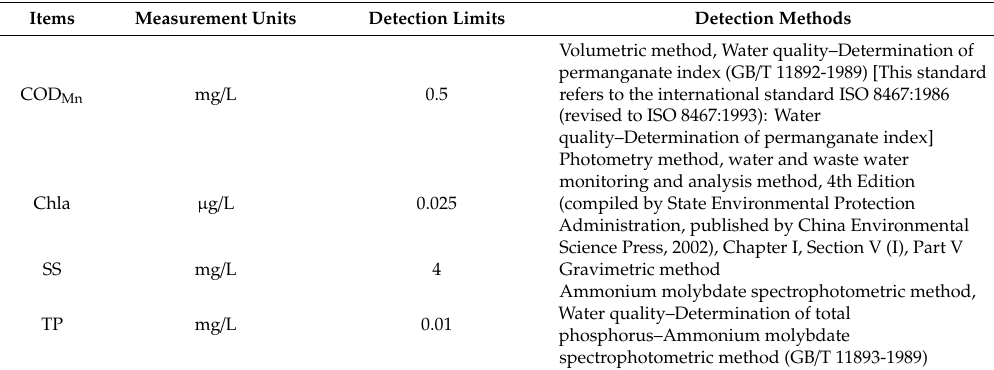
Table 2. The detection methods of water quality